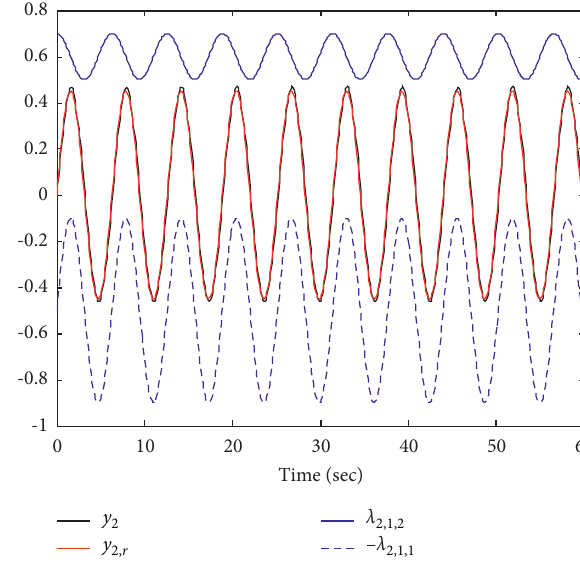
Figure 5: Trajectories of output y